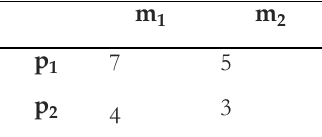
Table 5. Processing times of parts operations (seconds).